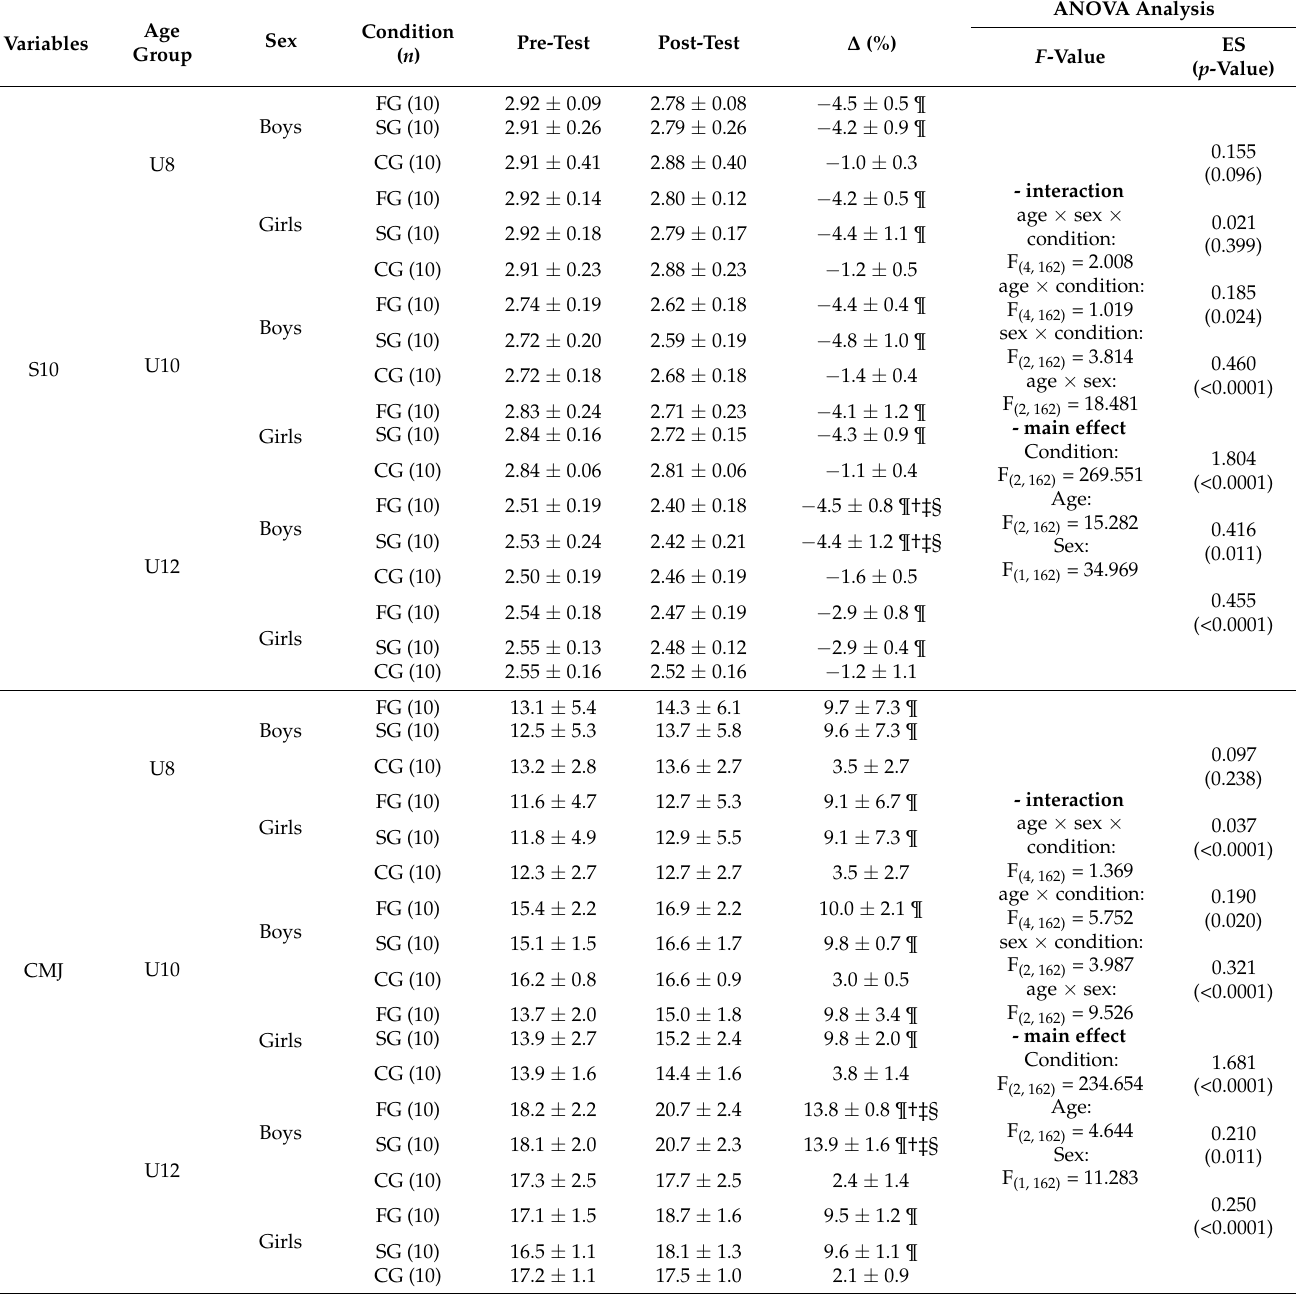
Table 3. Descriptive data for sprint (s) and jump (cm) performances in the surface-type plyometric training and control groups at pre-test and post-test ( n =